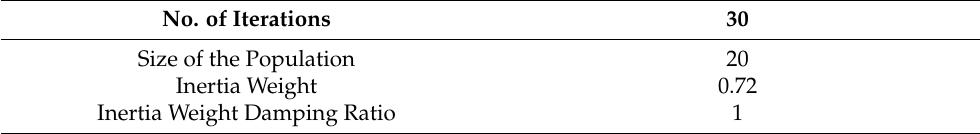
Table 1. Implemented PSO algorithm